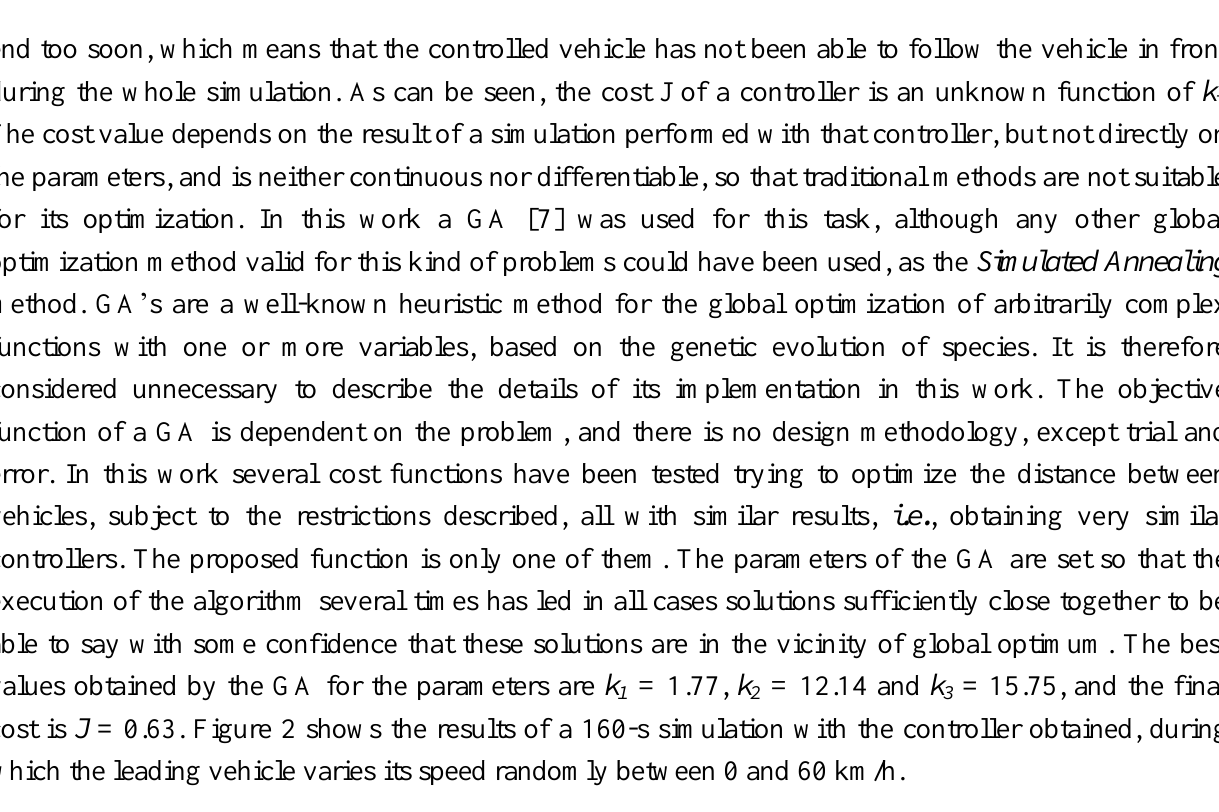
Figure 2. Result of a simulation with the controller obtained by the Genetic Algorithm. (a) Distance between vehicles, distance measured with the ultrasonic sensor (between 1 and 10 m), and braking distance. (b) Speed of both vehicles. (c) Actions on accelerator and